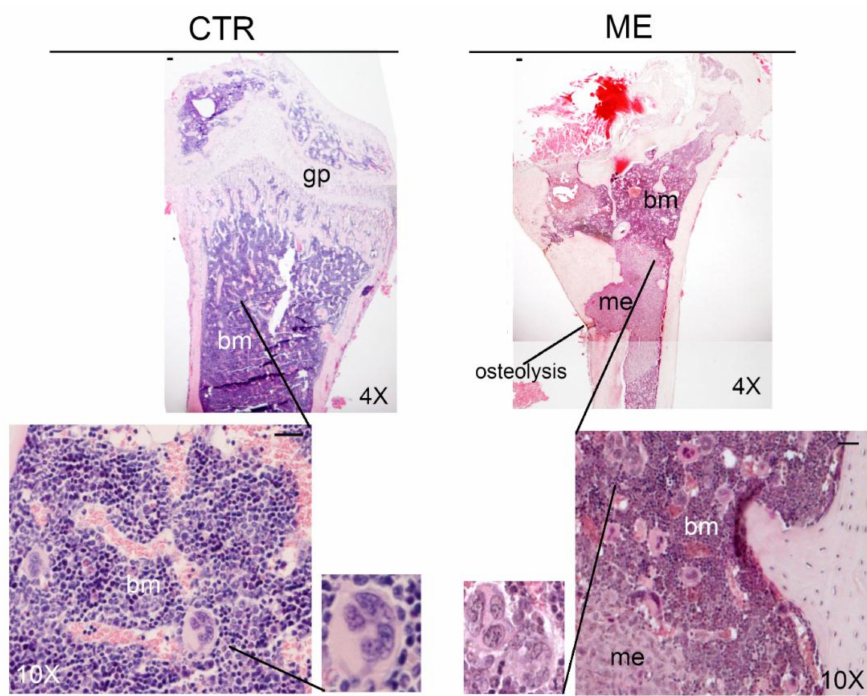
Figure 2. MK detection in bone marrow of control (CTR) and bone metastasis-bearing mice (ME). Representative images of haematoxylin and eosin (H&E) staining of femur sections in the context of our experiments, with the xenograft model of bone metastasis from breast cancer [52]. Three serial sections were analysed ( n = 3). Statistical analysis is reported in Supplementary Materials (Table